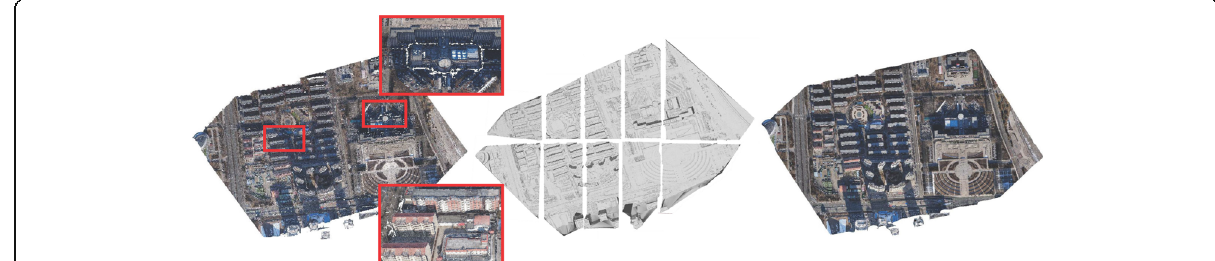
Fig. 1 City-scale scene surface modeling using the proposed scalable point-cloud-meshing method. The left is the input point cloud and two enlarged building areas. The middle is the result of incorporating region partitioning into local meshes, and the right is the final merged mesh with texture